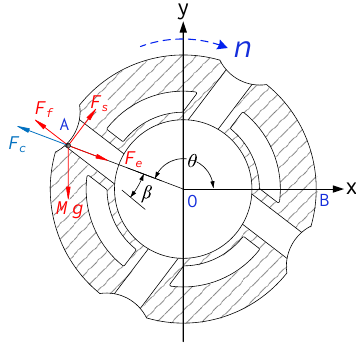
Figure 3. Mechanical model of drilling cuttings entering into the sieve holes of an SMH drill